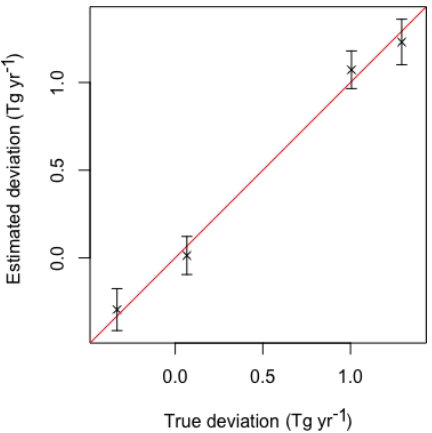
Figure 5. The inferred and true difference between UK emissions and a synthetic inventory value for each of the four time periods. The crosses show the inferred mean difference in total emissions with their associated 95% uncertainty. The red line indicates one- to-one